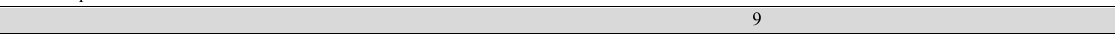
Organizational Commitment Reliability Statistics Result Cronbach’s Alpha